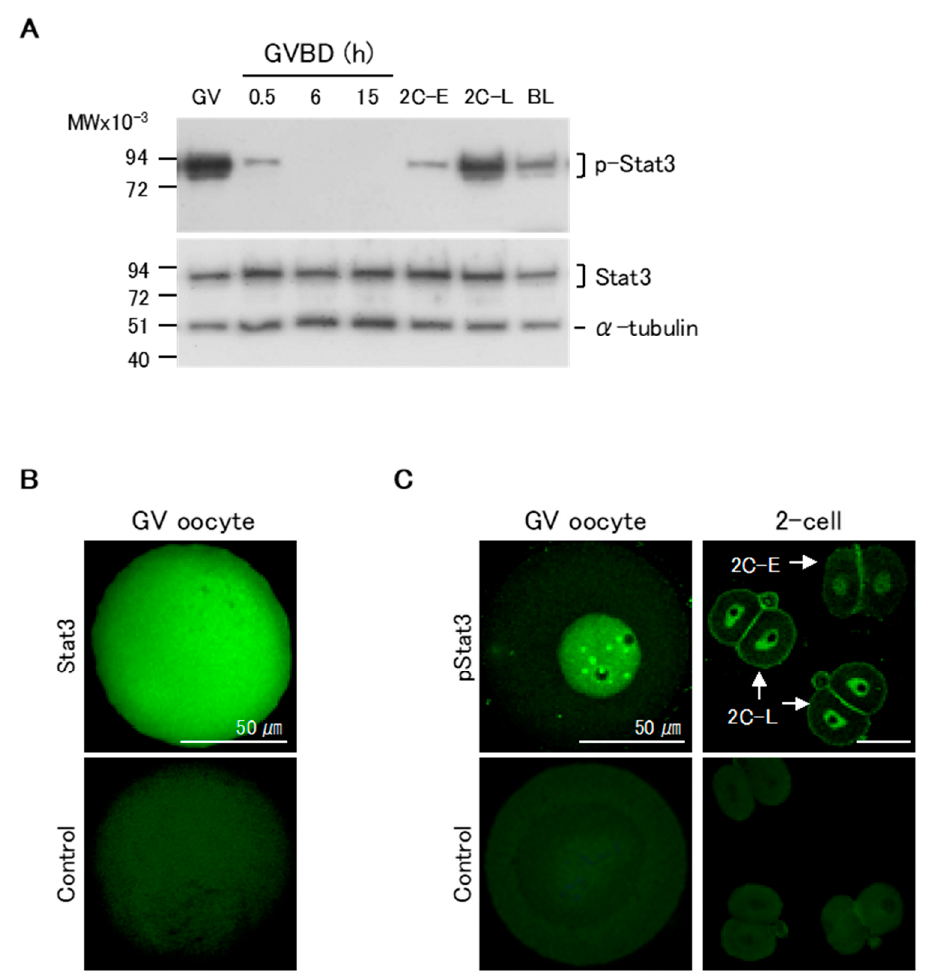
Figure 1. Patterns of expression of Stat3 and pStat3 in mouse oocytes and embryos. ( A ) Western blotting analysis. There is a considerable amount of pStat3 in the Germinal vesicle (GV) oocytes. At 0.5 h after germinal vesicle break down (GVBD), the amount of pStat3 decreases suddenly, and pStat3 cannot be detected until 15 h after GVBD. pStat3 is detected as a weak signal at the early 2-cell stage (2C-E) and a strong signal at the late 2-cell stage (2C-L). Conversely, a certain amount of Stat3 protein is detected at all stages. BL: blastocyst. ( B ) Immunocytochemical analysis reveals that the Stat3 protein is present in the whole cell. ( C ) Conversely, pStat3 exists in the nucleus in the GV oocyte and 2C-L (arrows). A weak signal of pStat3 is observed in the nucleus of 2C-E (arrow). Stat3 and pStat3 signals are shown in green color. As a negative control, the samples were incubated with the secondary antibody alone.